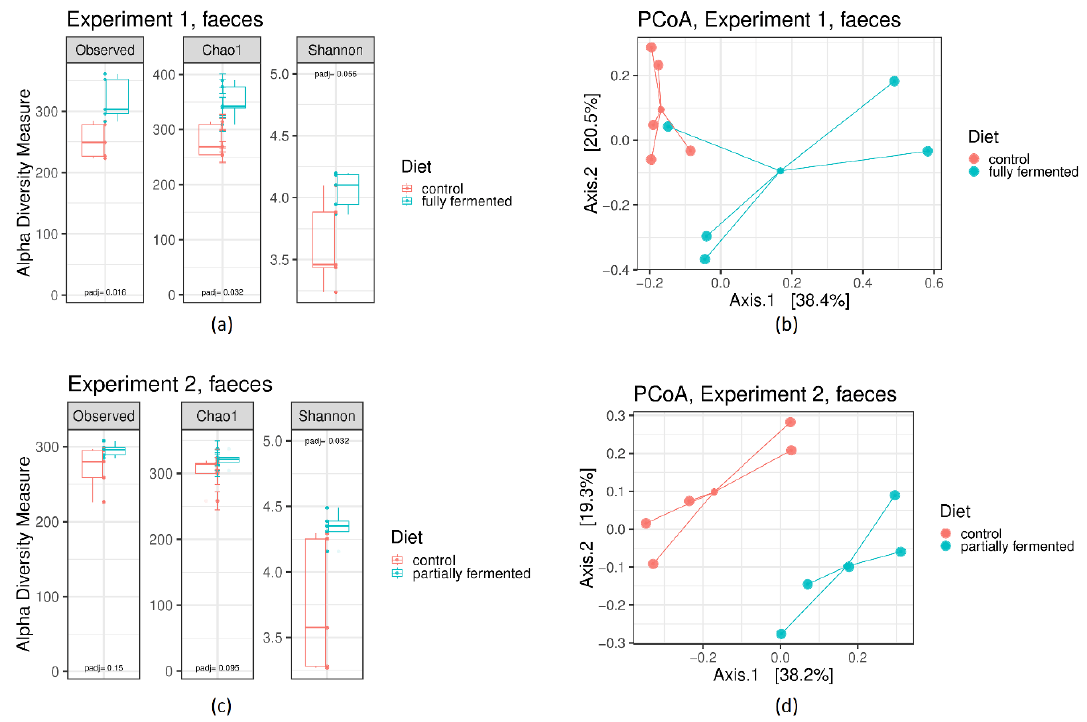
Figure 2. Alpha diversity in the faecal samples (day 21 of the experiment) depending on experiment and dietary treatment. Box plots showing alpha diversity in samples using the species richness estimators of the Observed Species, Chao1 and Shannon indices. Comparisons of the species richness estimators were done by the Wilcoxon rank sum test with p -value adjustment method: holm. A Bray-Curtis dissimilarity-based principal coordinate analysis (PCoA) was performed on the faecal samples. Each point represents a di ff erent animal; colored lines connect animals of one dietary treatment (control, fully fermented or partially fermented): ( a ) Alpha diversity in Experiment 1; ( b ) PCoA in Experiment 1; ( c ) Alpha diversity in Experiment 2; in ( d ) PCoA in Experiment 2.